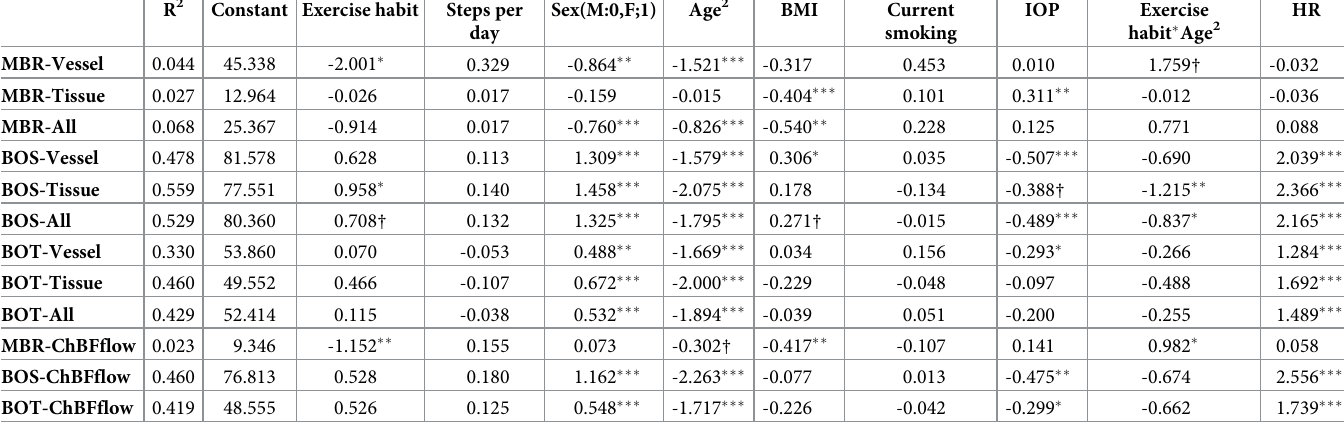
Table 5. Results of the multiple regression analysis for factors independently contributing to the item of ocular microcirculation, using the self-reported exercise habits. R 2